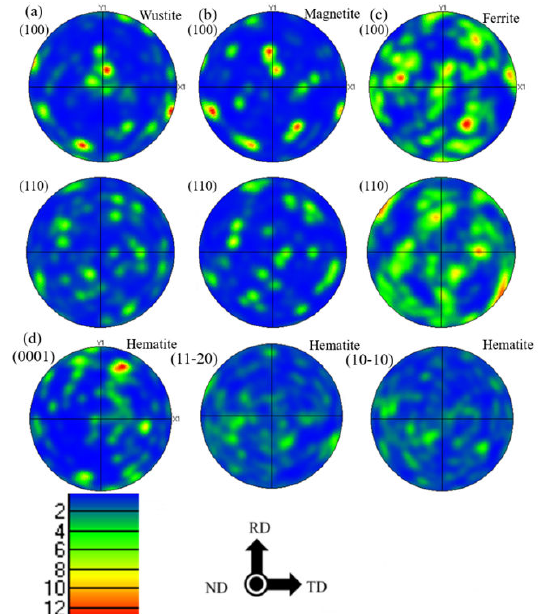
Figure 10. Polar diagrams of oxide layer and steel matrix on different crystal planes for ( a ) FeO, ( b ) Fe 3 O 4 , ( c ) ferrite, and ( d ) (0001), (10 − 10) and (11 − 20) PF for Fe 2 O 3 , with a TR of 15%, and a CR of 18 ◦